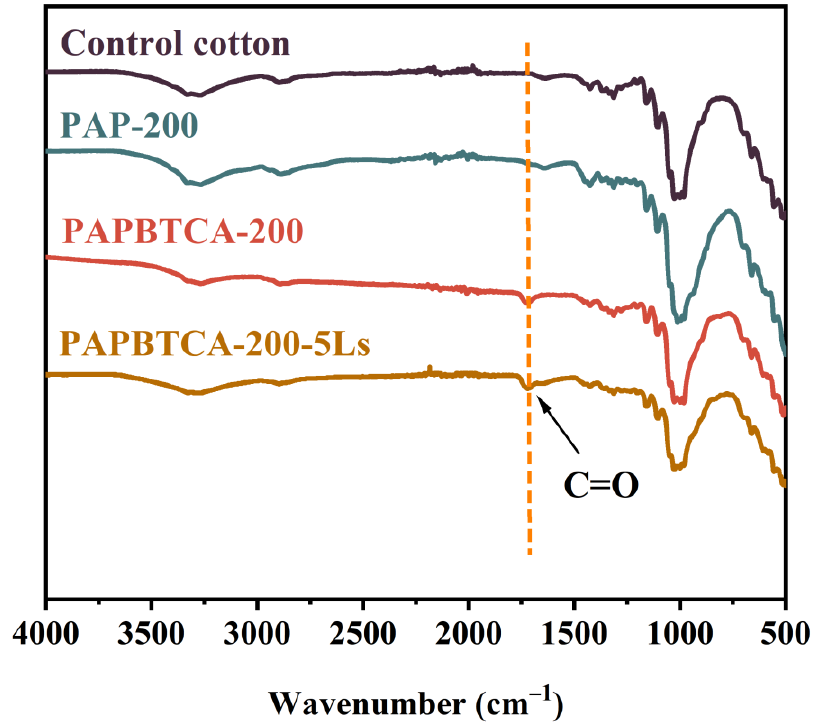
Figure 1. FTIR spectra of the treated and untreated cotton fabrics.